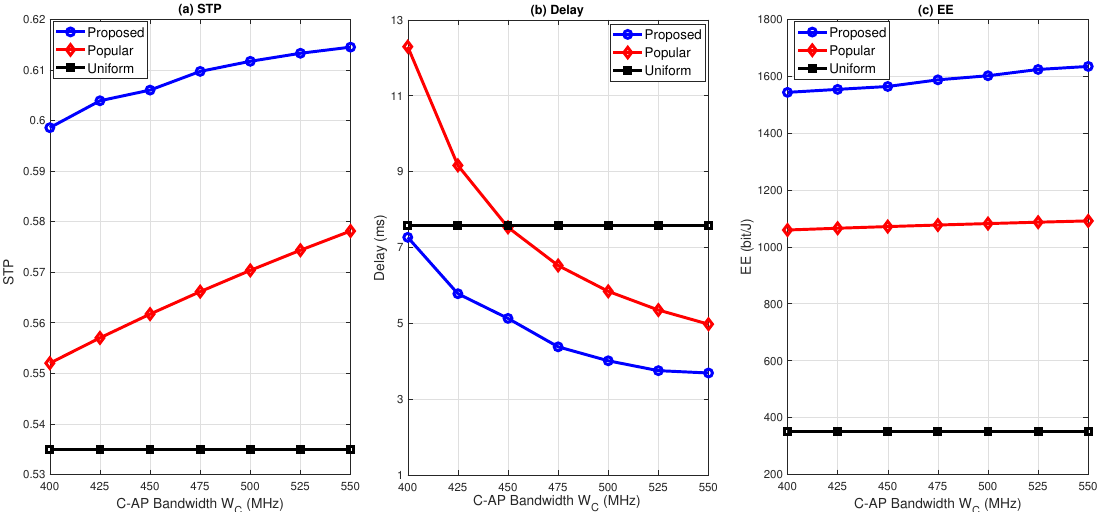
Figure 6. STP, delay, and EE versus C-APs’ bandwidth when M = 20 contents, λ U = 0.1 users/m 2 , λ F = 0.01 F-APs/m 2 , λ C = 0.0001 C-APs/m 2 , R = 150 m, γ = 0.8, α = 4, P F = 30 dBm, P C = 40 dBm, P s = 37 dBm, ρ = 15.13, W F = 100 MHz, T = 1 ms, and τ = 0.1